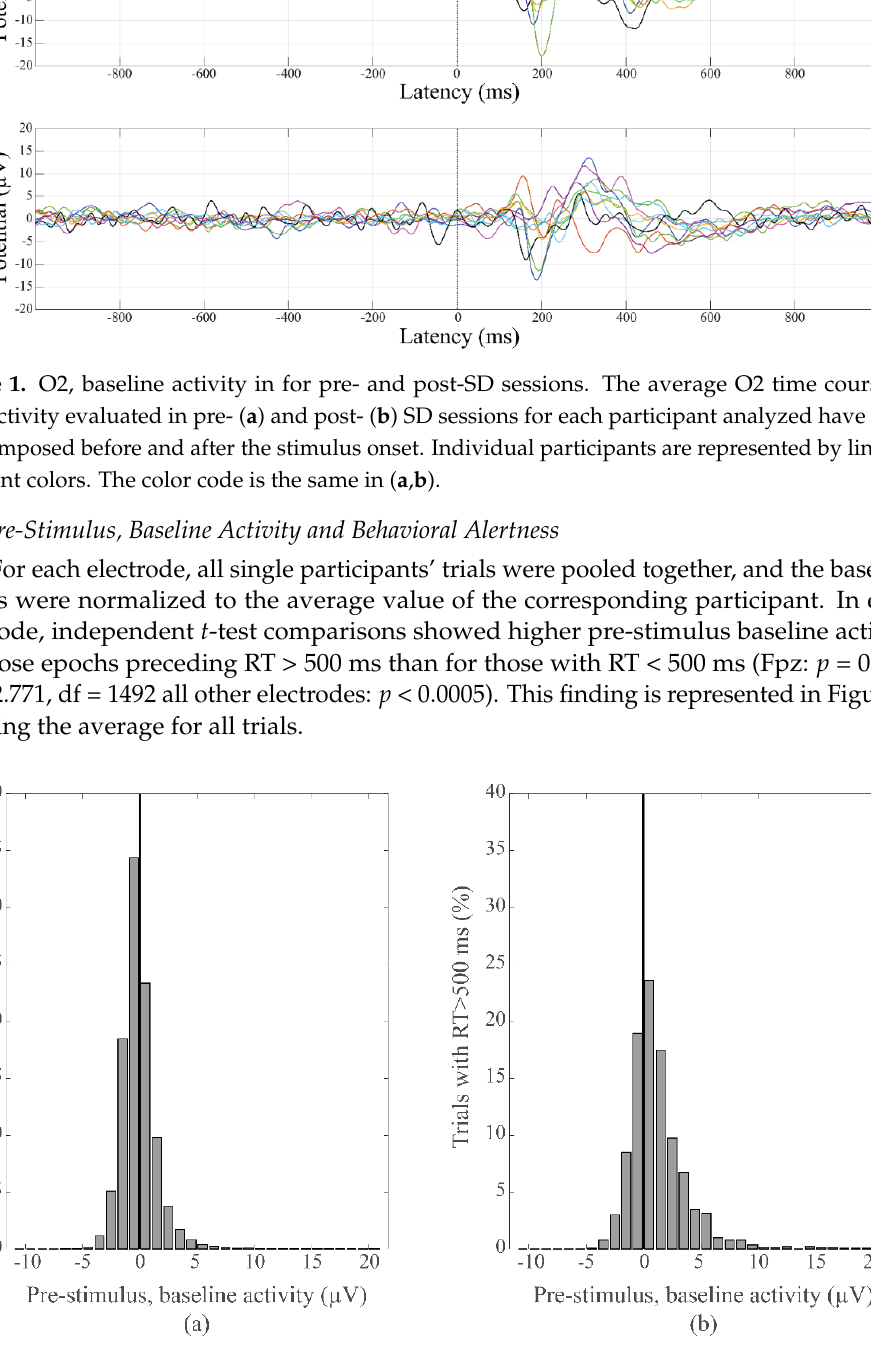
Figure 2. Data distribution of the normalized baseline activity preceding normal responses ( a ); RT < 500 ms; n = 26980, mean ± SD: − 0.07 ± 1.81 and lapses ( b ); RT > 500 ms; n = 1406, mean ± SD: 1.32 ± 2.85; p < 0.0005. The continuous vertical line shows the 0 µ V. These graphs highlight how the mode of baseline activity preceding lapses is above the 0 µ V vertical line ( b ), while the mode for the normal responses remains below ( a